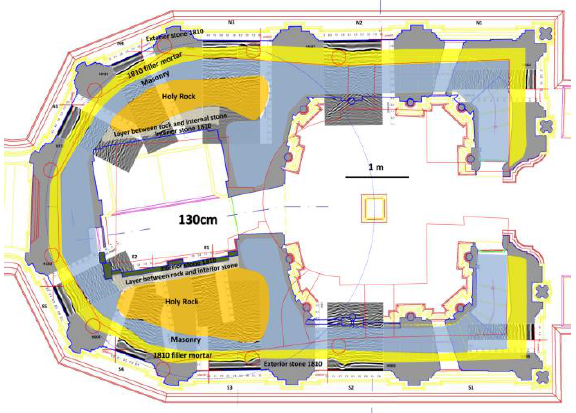
Figure 14: Plan (at 130cm height relative to the interior floor level) indicating the results from the prospection analysis of the internal structure of the Holy Aedicule with ground penetrating radar at its surfaces. Yellow zone corresponds to the filler mortar. Blue zone corresponds to the main masonry. Orange areas corresponds to the two rock blocks (north and south respectively), which correspond to the remnants of the original monolithic Holy Aedicule.